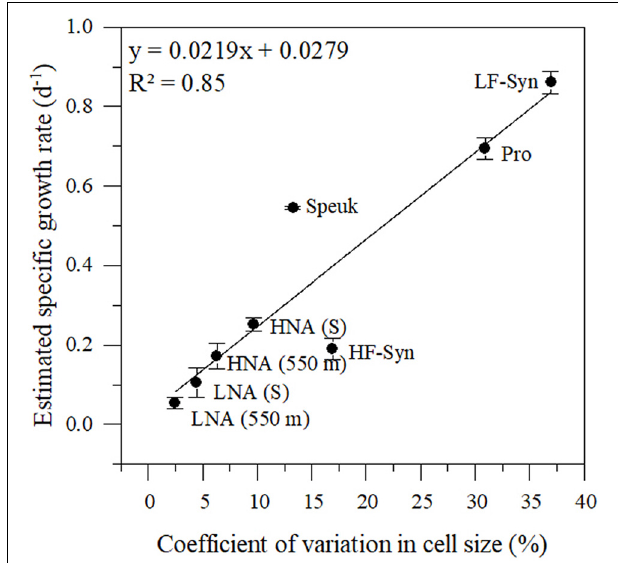
FIGURE 4 | Relationship between the diel coefficient of variation in cell size measured over 24 h from in situ samples and the estimated specific growth rate from the incubation experiments conducted in winter. Pro, Prochlorococcus ; LF-Syn, low phycoerythrin fluorescence Synechococcus , HF-Syn, high phycoerythrin fluorescence Synechococcus ; Speuk, small picoeukaryotes; LNA, low nucleic acid content; HNA, high and low nucleic heterotrophic prokaryotes. Samples were collected from the surface (S) and 550 m depth. See details in the main